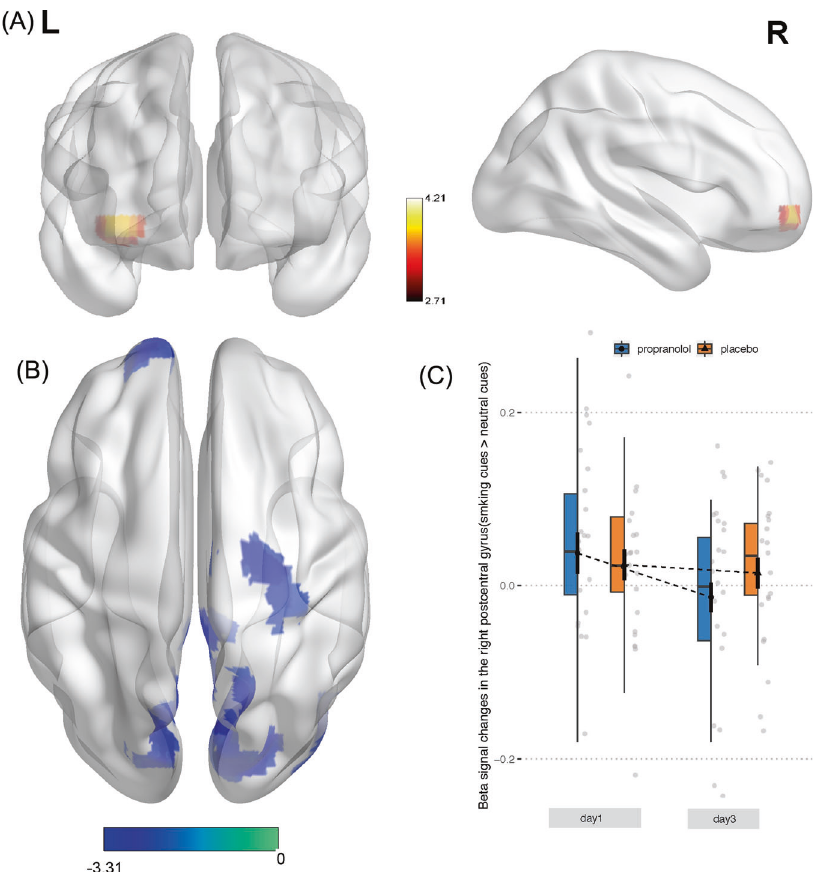
Fig. 5 Alteration of brain reactivity to smoking-related cues after the reconsolidation manipulation. A Brain regions that showed an increase in activation in response to smoking-related cues compared with neutral cues in the propranolol group on day 3 (propranolol > placebo). B Brain regions that showed a decrease in activation in response to smoking-related cues on day 3 compared with day 1 in the propranolol group (propranolol > placebo). C Decrease in reactivity of the postcentral gyrus to smoking-related cues after the reconsolidation manipulation in the propranolol